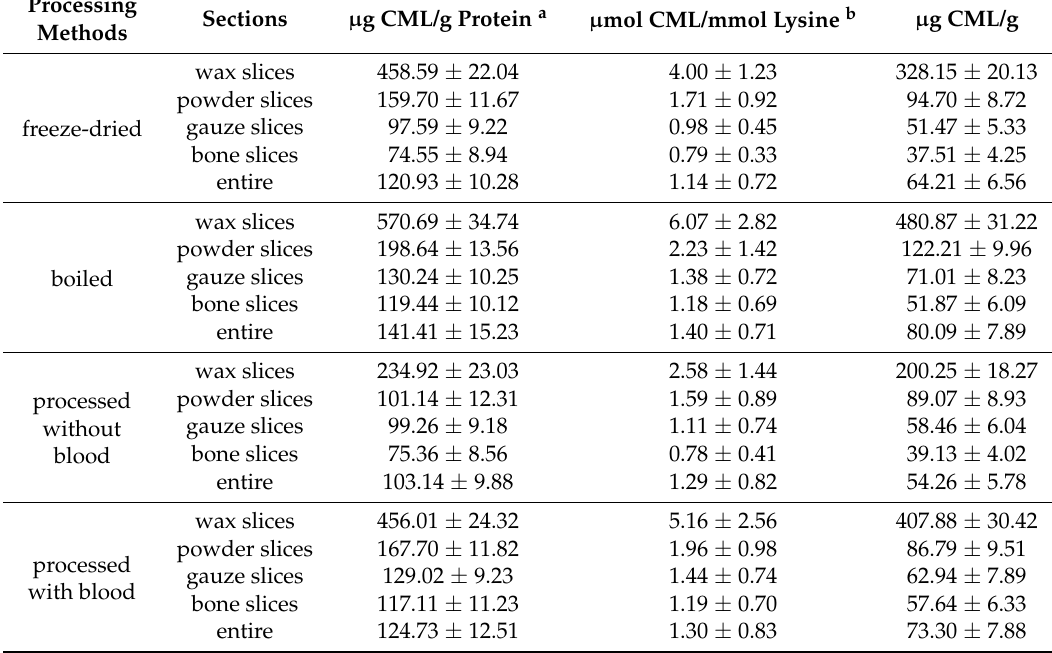
Table 2. CML contents in different sections of antler velvet with different processing methods expressed per µ g/g protein, µ g/g, and µ mol/mmol